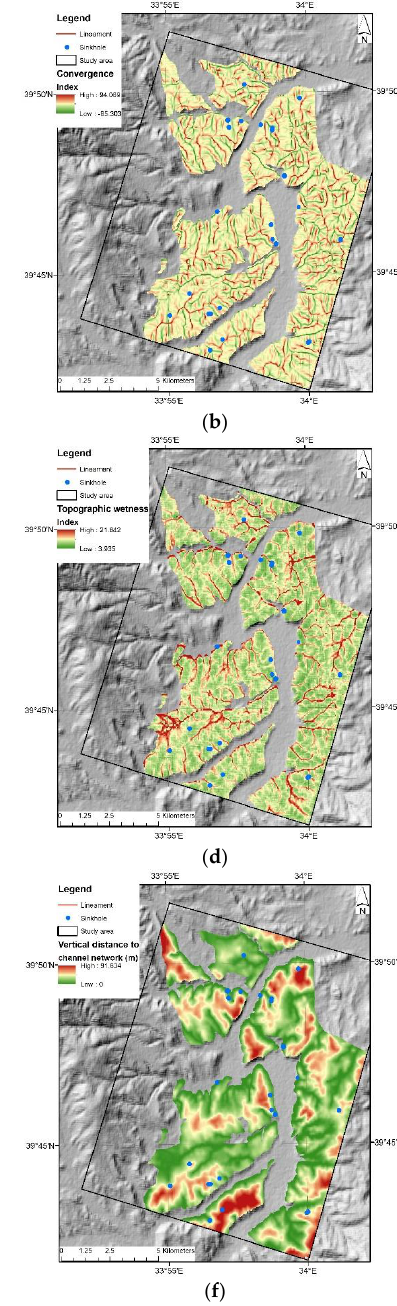
Figure 7. The DEM generated from the Sentinel-1 datasets for 2018 ( a ); the spatial distributions of convergence index ( b ), closed depressions ( c ) topographic wetness index ( d ), slope length factor ( e ), and vertical distance to channel network ( f ) in the study